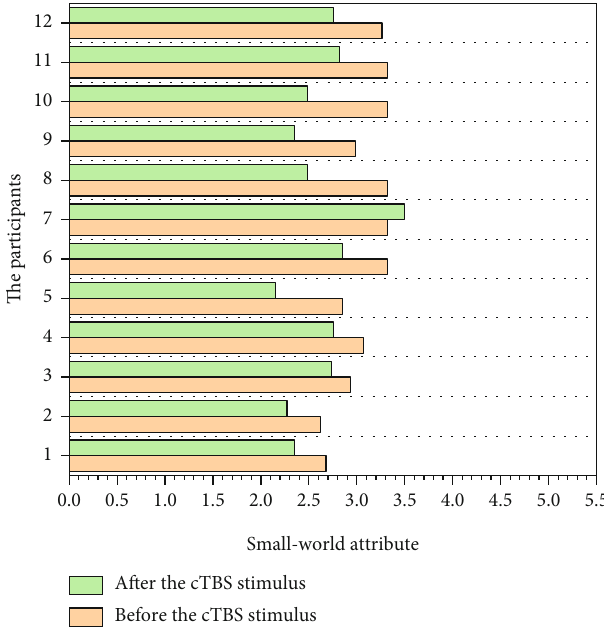
Figure 9: Network small-world attributes before and after cTBS stimulation. Table 2: Statistical test table of network parameters.